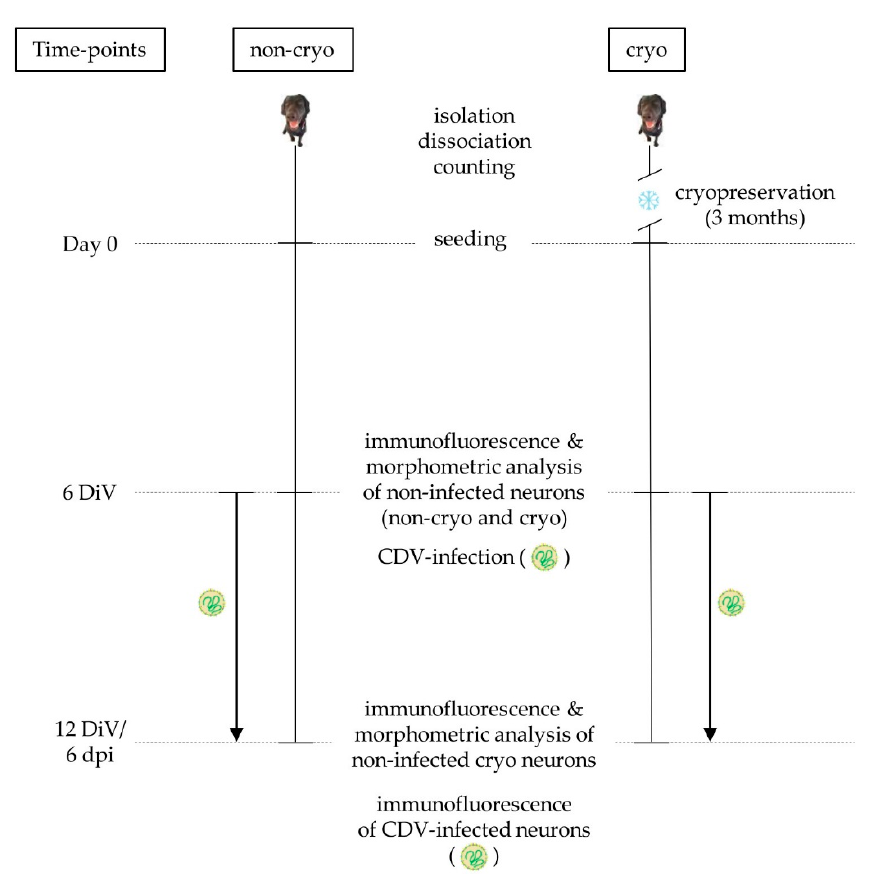
agent, 31.5% FCS, 0.65% penicillin-streptomycin (PS, PAA Laboratories GmbH; Pasching,